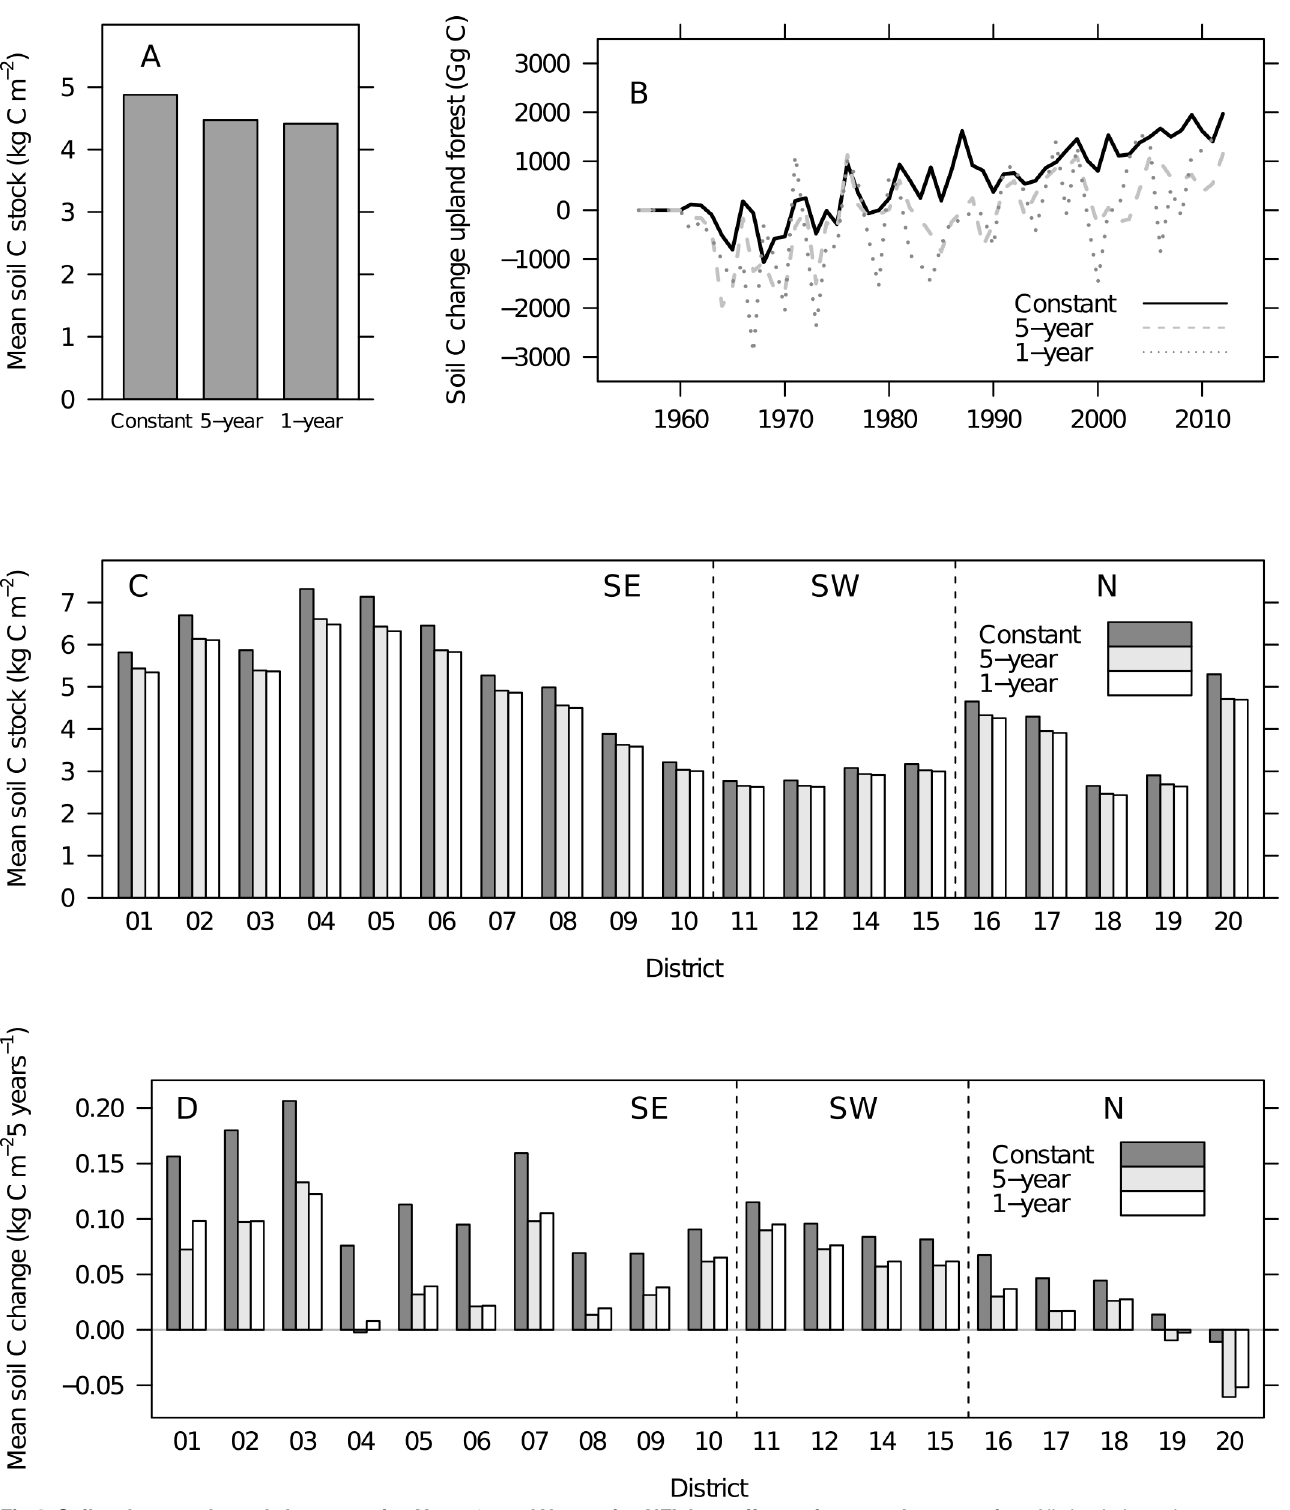
Fig 4. Soil carbon stocks and changes using Yasso07 and Norwegian NFI data – effects of temporal aggregation. All simulations shown were run for each of 11275 NFI plots using plot-specific climatic input including the 1961 – 1990 mean climatic values for spin-up. For the time series following the spin-up calculation, the simulations differed by representing three levels of temporal aggregation of climatic data: constant mean values, 5-year mean, and annual